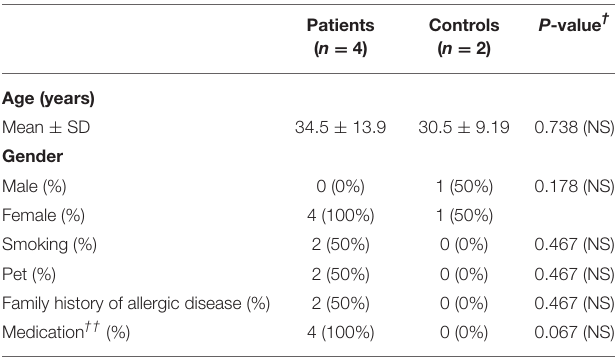
TABLE 3 | Demographic data of patient and control subjects recruited in this study.